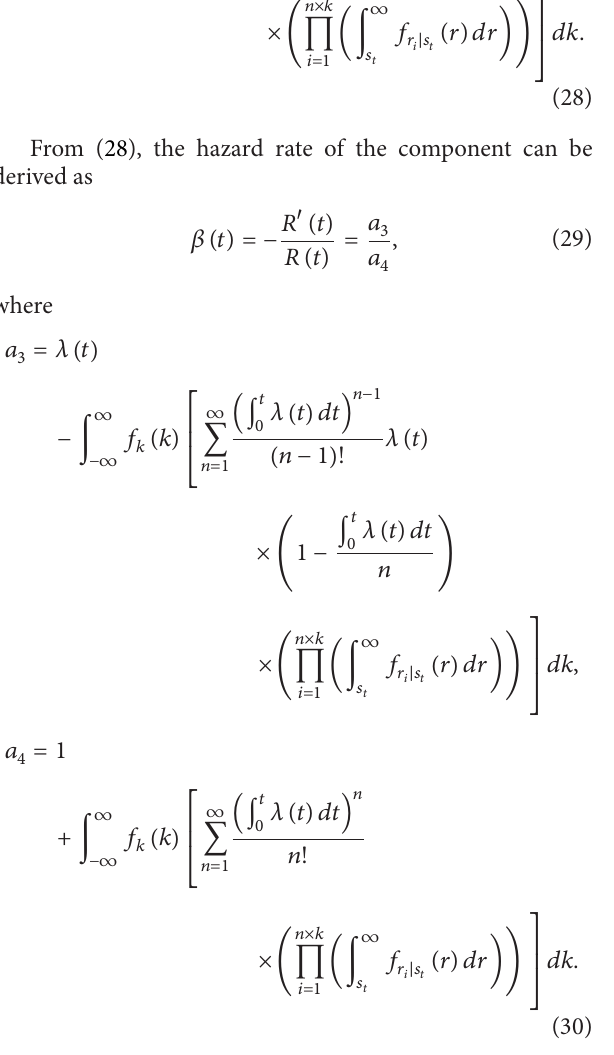
7 100 MPa and 𝐶 = 10 , 𝛼 = 1 , and 𝑚 = 2 . The initial strength 𝑟 0 follows the 𝑠 -normal distribution with the mean value of 200 MPa and the standard deviation of 20